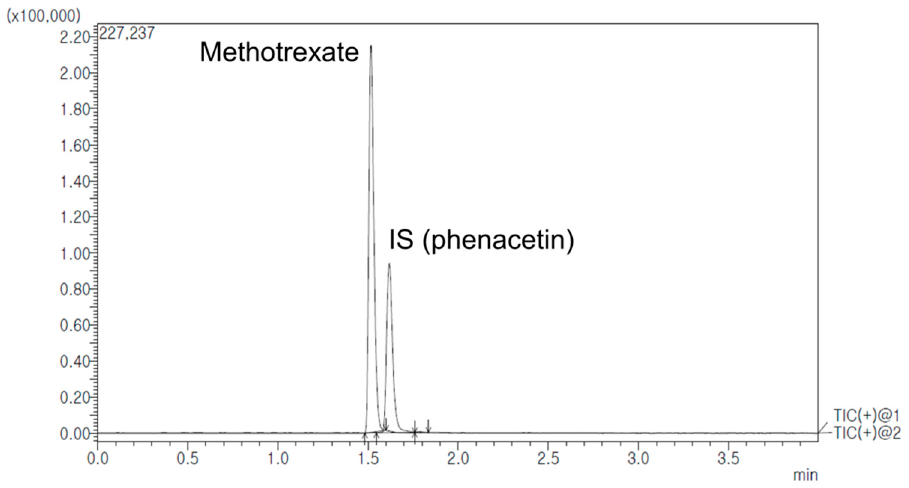
Figure 9. Representative chromatograms of MTX and internal standard (IS) obtained in multiple reaction monitoring (MRM) positive ion mode of UPLC-MS/MS.